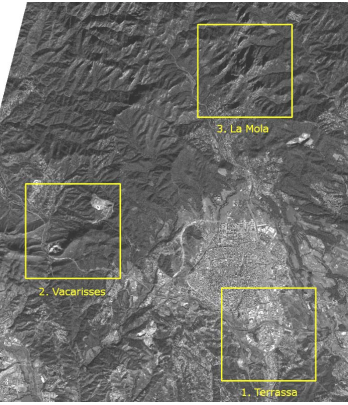
Figure 2: Overview of the three test areas (Reinartz et al. 2010)